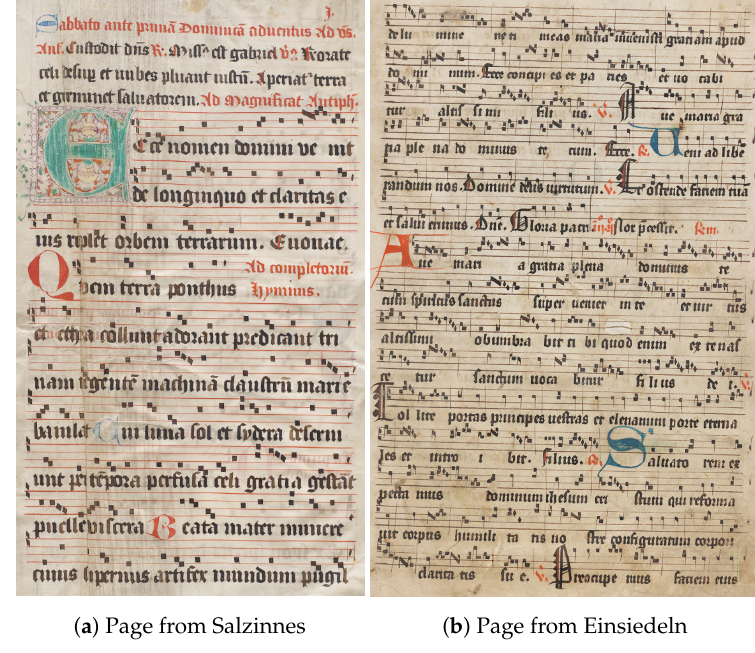
Figure 6. Example of pages from the corpora used in this work.